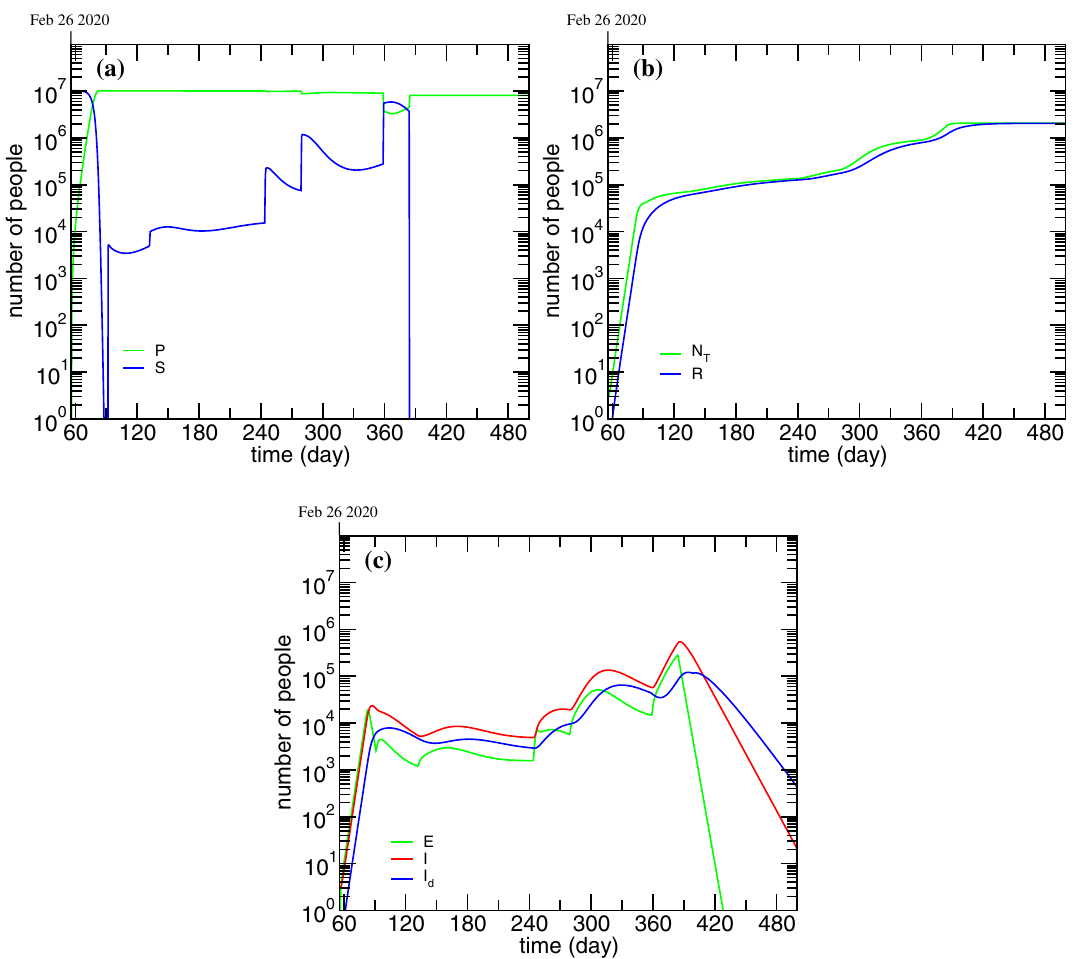
Figure 4. Time evolution of the total cases and of the modified PSEIRD(S) model compartments for which there is no available data or the data is not consistently reported: ( a ) P and S ; ( b ) NT d and R ; ( c ) E , I and I d - c). The plots were obtained taking into account the same assumptions for the fixed parameters presented in Table 2 and the same optimized parameters presented in Table 2.